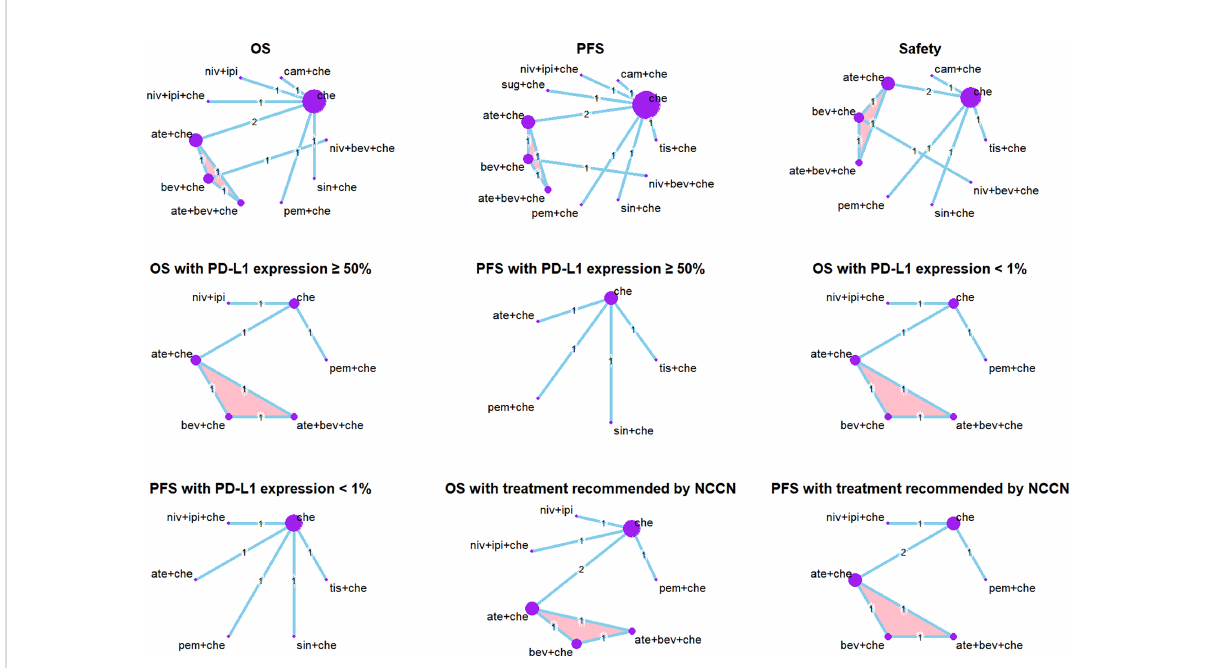
FIGURE 2 Network plots. Each circle represents an intervention as a node in the network. The size of the circle is proportional to the number of randomized controlled trials. Multi-arm study is highlighted. Safety: the network plots of analysis of AEs of any grade and grade ≥ 3 AEs are the